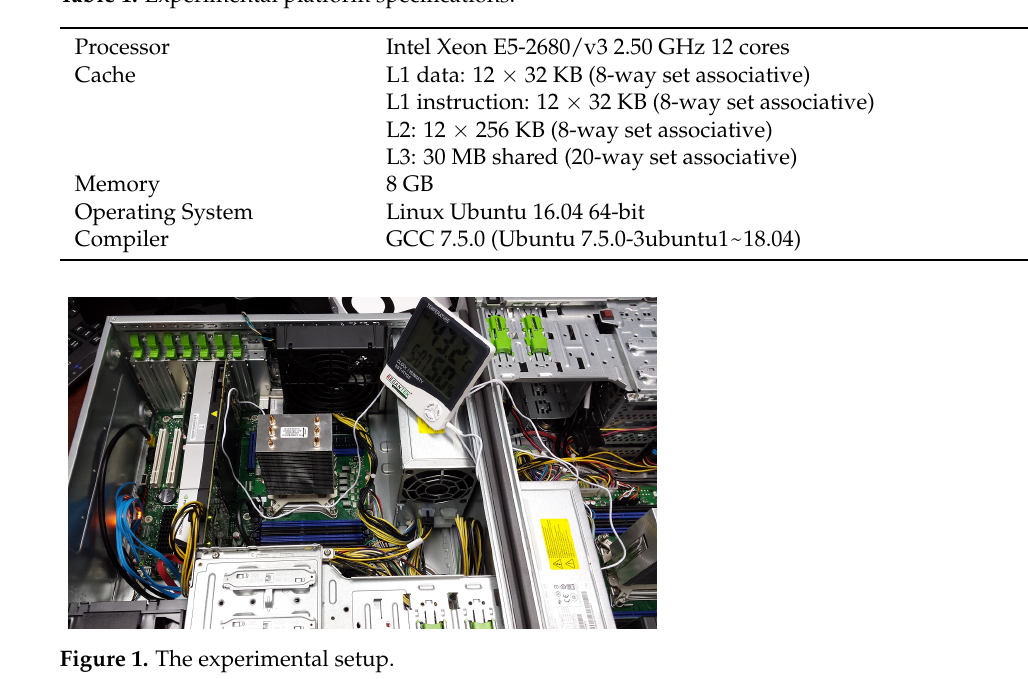
Table 1. Experimental platform specifications.